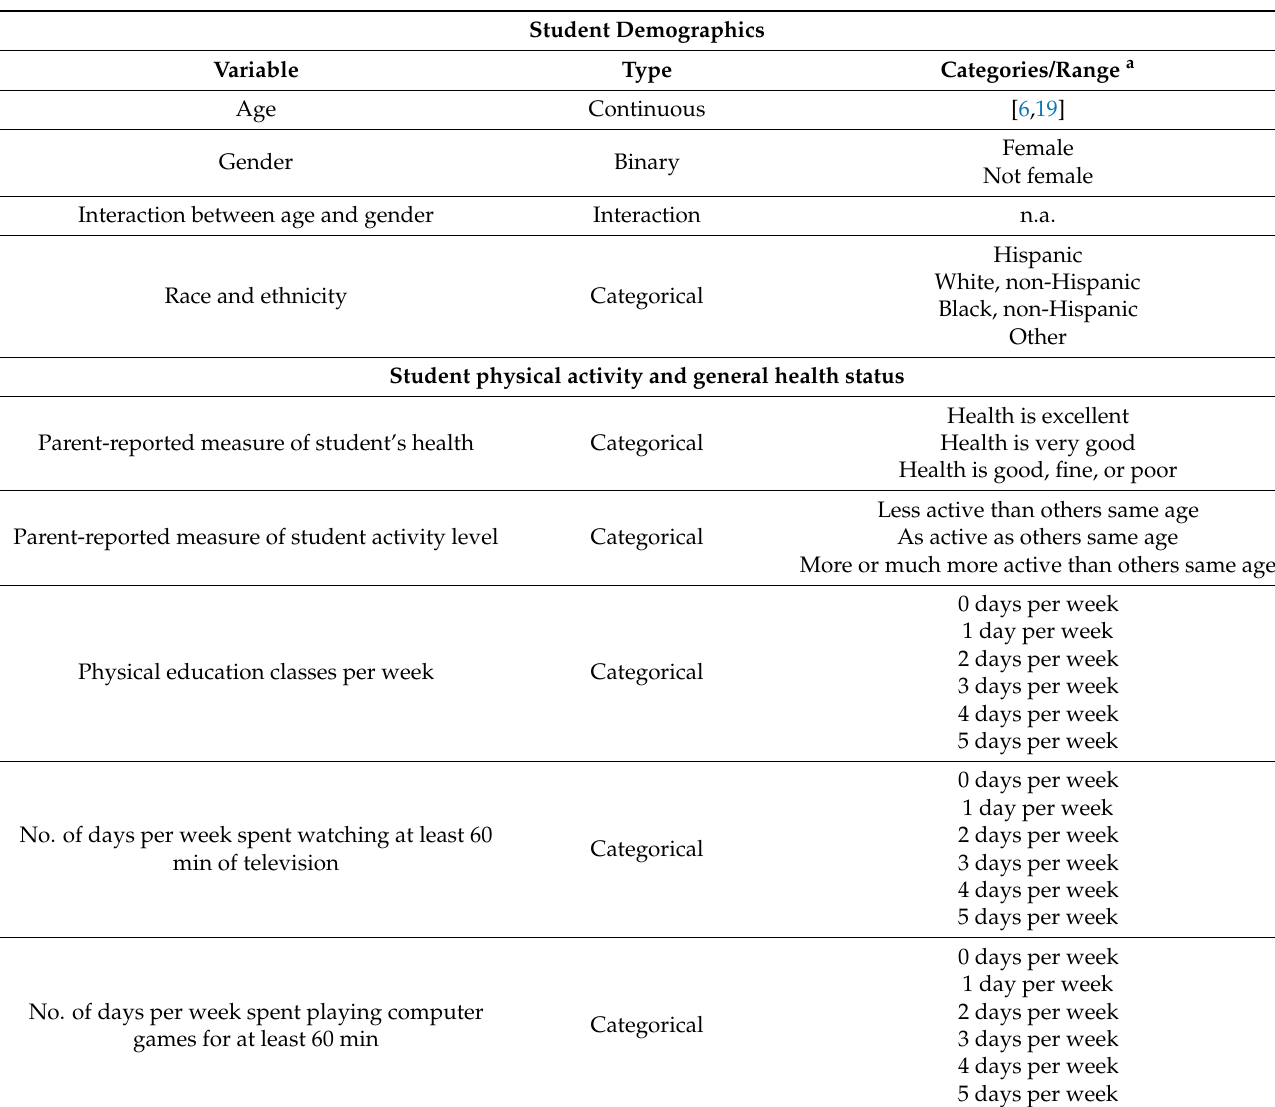
Table A2. Student and household characteristics included as model